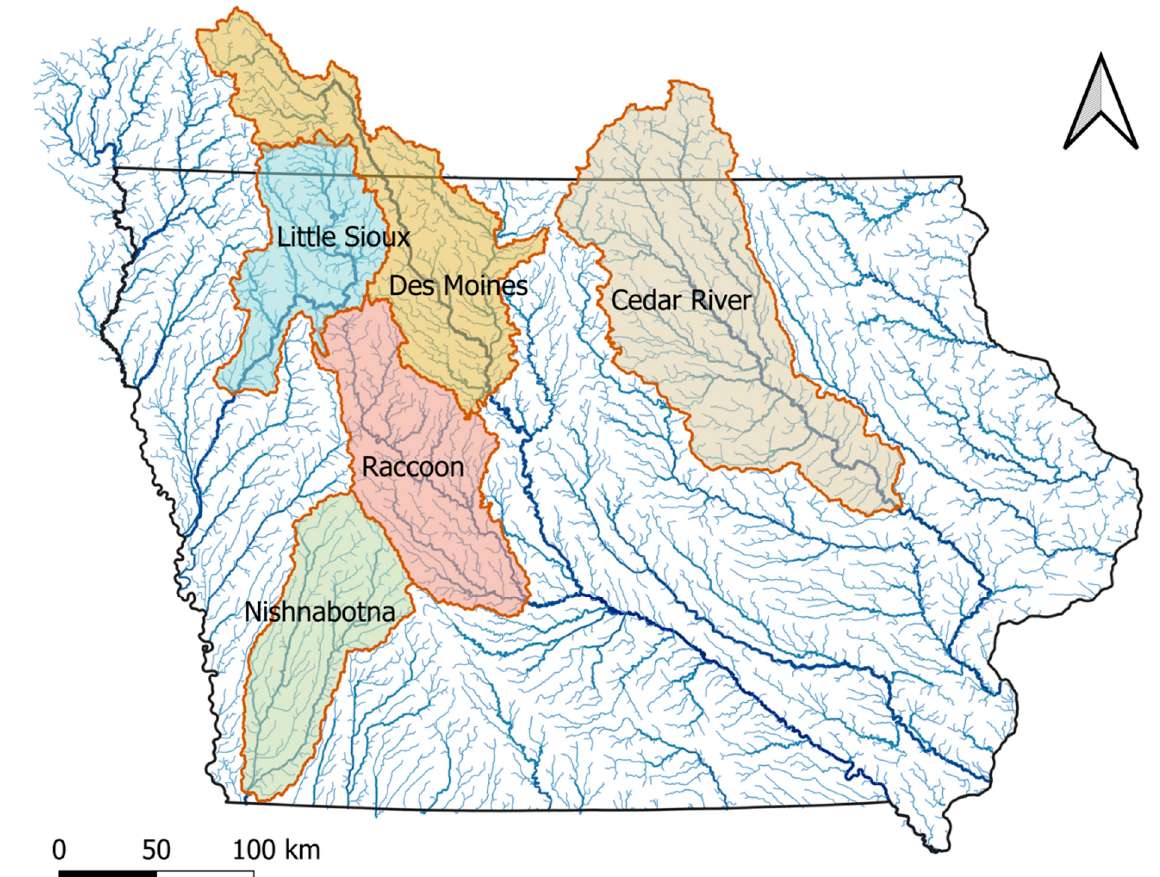
Figure 2. Basins selected to evaluate the model implementation.